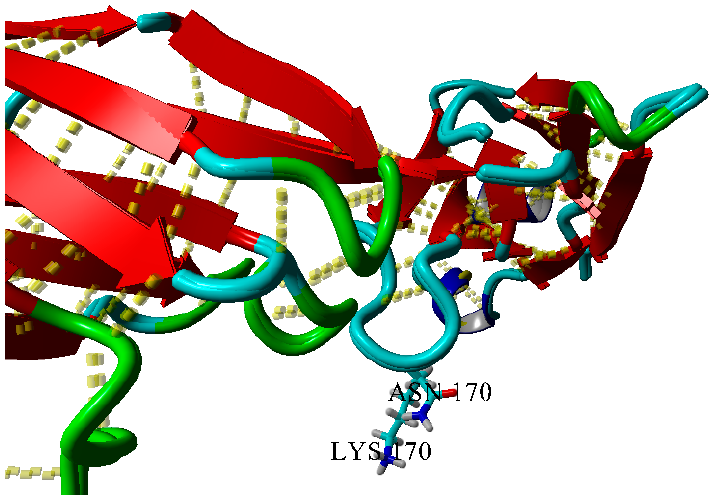
Figure 4. Superposition of wild-type and K170N BIF variants. 3D dashed lines show hydrogen bonds.